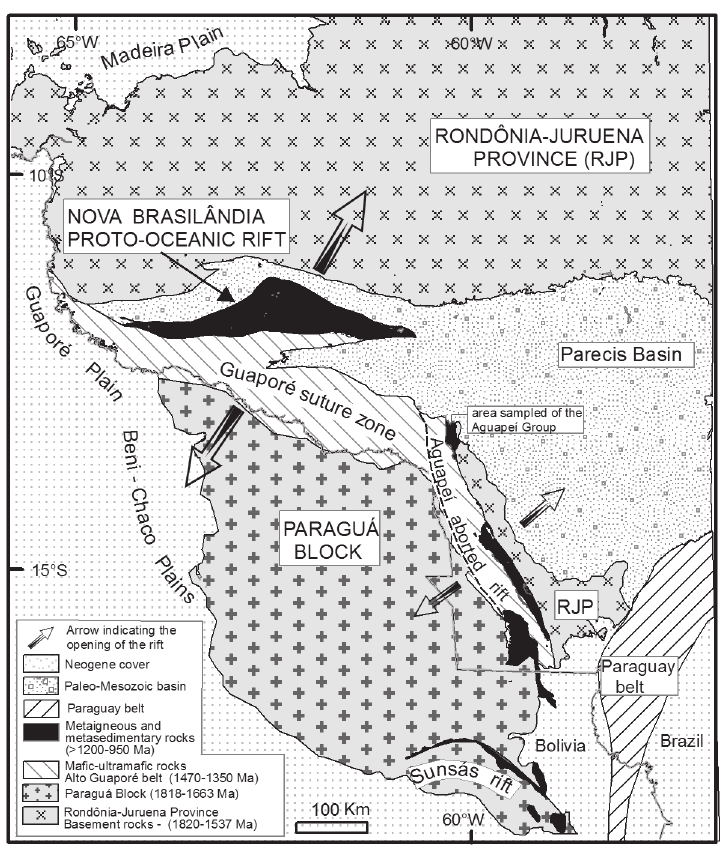
Figure 2 - Geotectonic map of the southwestern Amazonian craton highlighting the Nova Brasilândia, Aguapeí and Sunsás